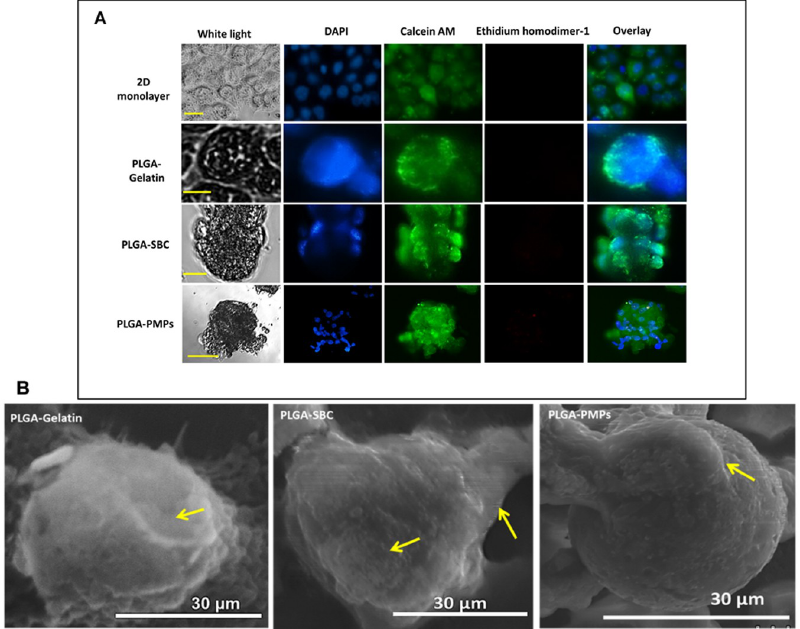
Fig 4. Cellular viability on porous MPs. (A) Live/dead and DAPI stained particles after 1-day culture indicating that the A549 lung cancer cells could attach onto the fibronectin-coated particles within 24 hours and were viable (green = live, red = dead, Scale = 10 μ m). (B) SEM images of cell attachment on PLGA-Gelatin, PLGA-SBC and PLGA-PMPs demonstrate that the cells were clearly seen attached onto the surface of the MPs (arrows).